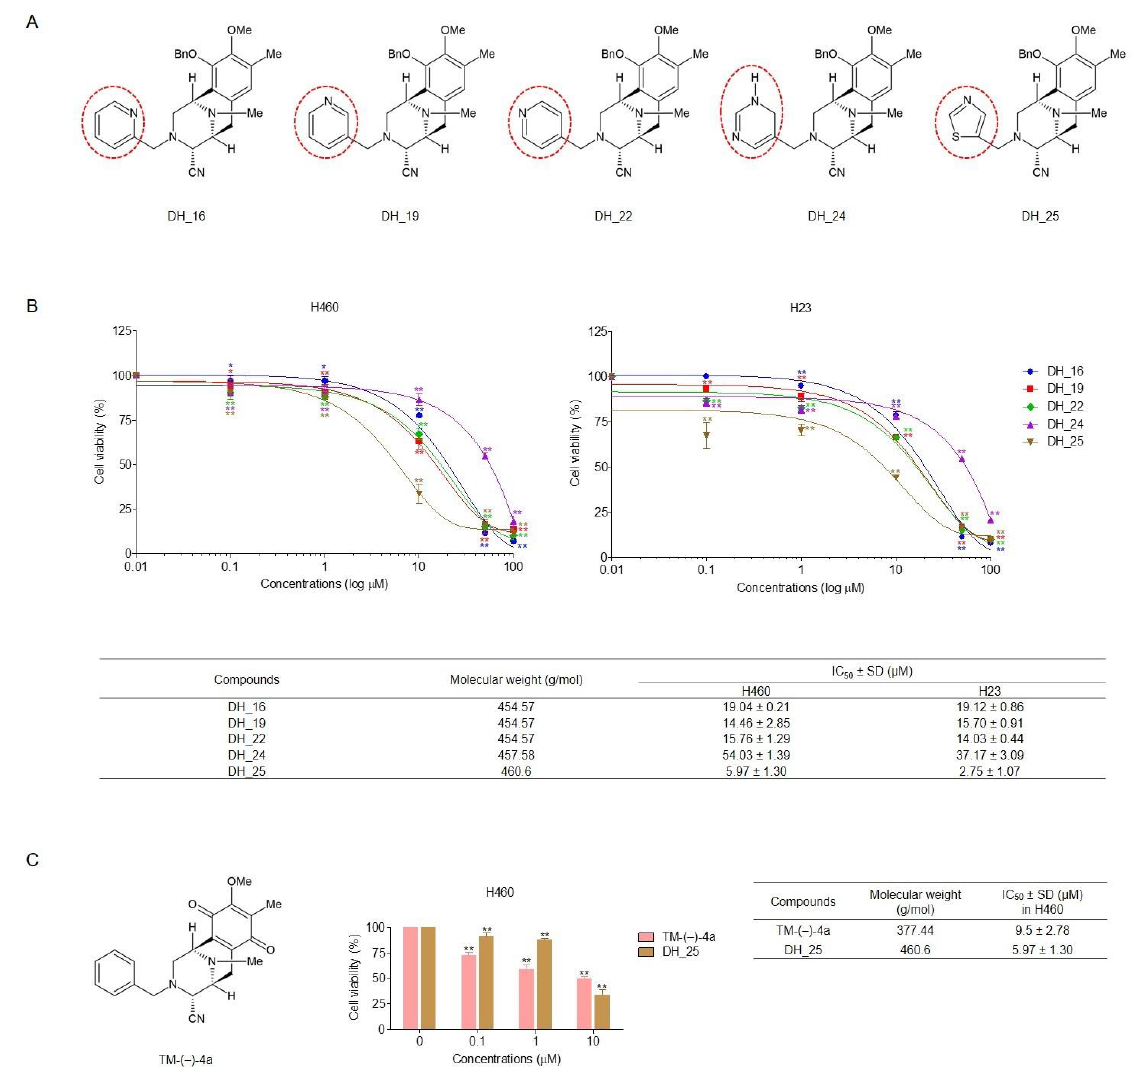
Figure 1. Derivatives of RT right-half analogs (DH_16, DH_19, DH_22, DH_24, DH_25, and TM-( –